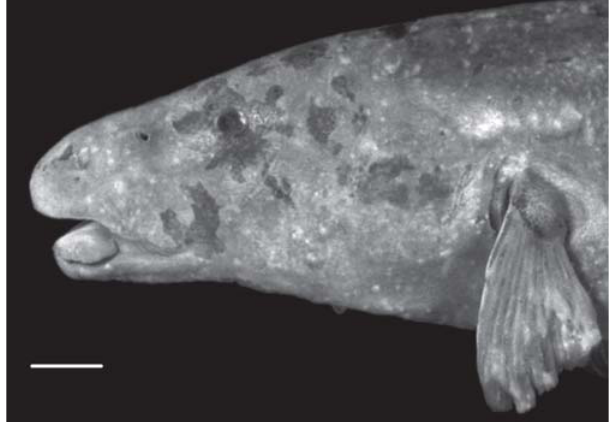
Fig. 1. Holotype of Tembeassu marauna (MZUSP 48510), left side of head. Scale bar ~ 5